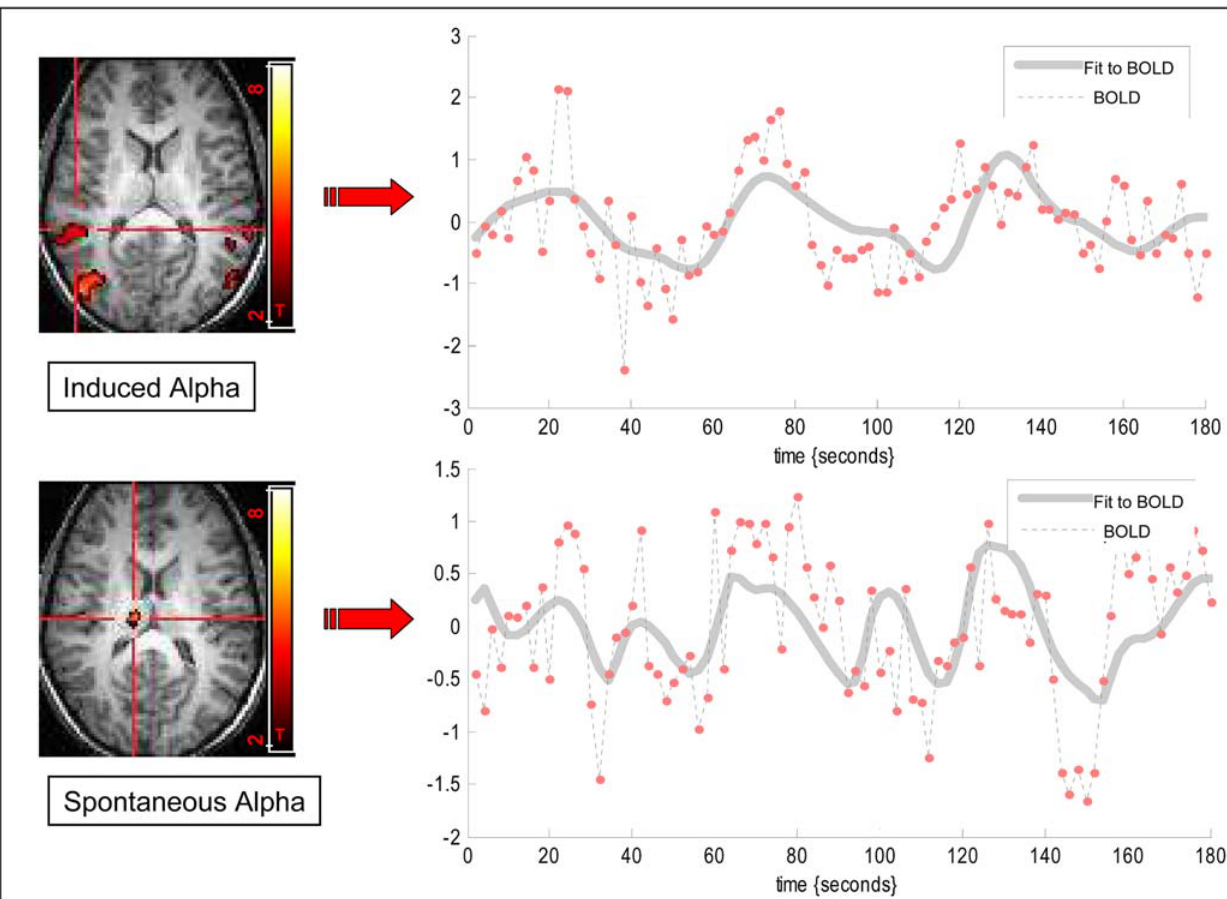
Figure 5. BOLD time course related to spontaneous and induced alpha networks. BOLD time course of a single subject was extracted from induced alpha region of interest (ROI) in left STS (top, P , 0.0001) and from the spontaneous alpha network in the thalamus (bottom, P , 0.0001). The dashed line denotes the measured BOLD time course and the grey line denotes best fit to BOLD oscillations. It is evident that the BOLD time course extracted from the induced alpha network corresponds to the paradigm based alpha modulation while the time course based on spontaneous oscillations corresponds to the on-going alpha modulation.